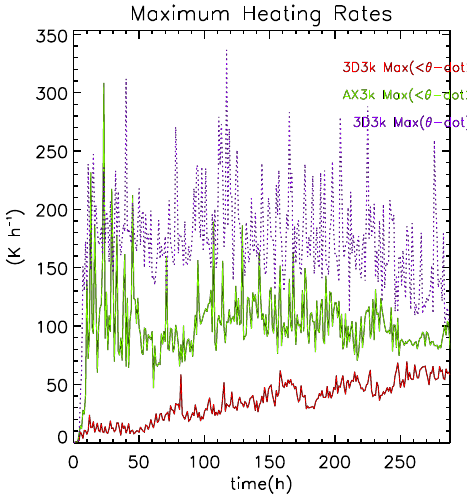
Fig. 7. The maximum azimuthally averaged heating rate from the 3D3k (red) and AX3k (blue) simulations plotted against instanta- neous intensity (e.g., Fig. 1.